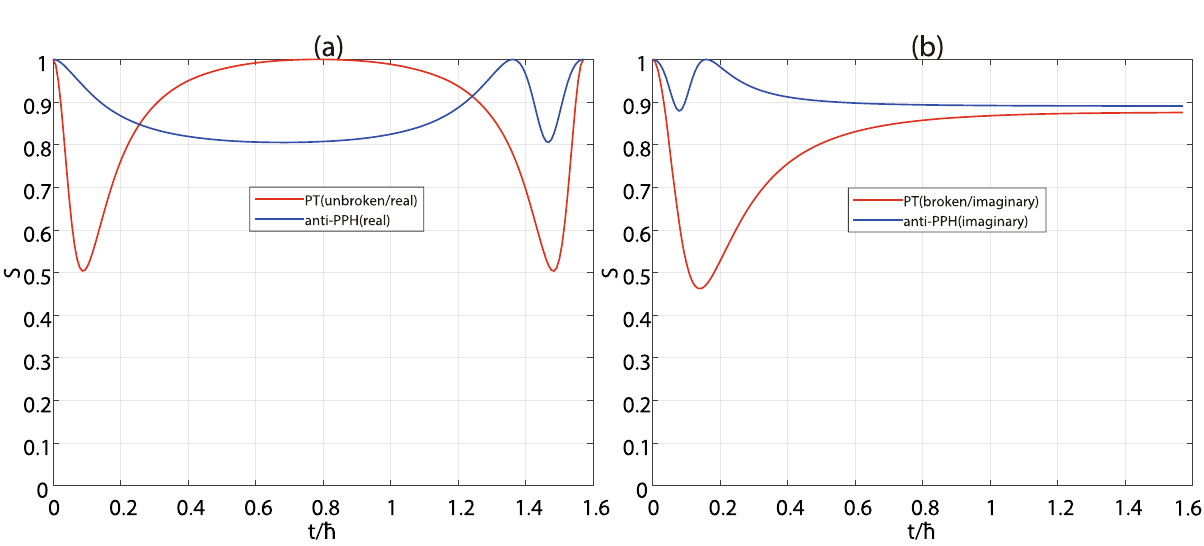
Figure 4. Distinguishability of the entropy dynamics of the anti-PT-symmetric and PPH systems. ( a ) With |+� input in the first step, the anti-PT-symmetric system can be distinguished from other systems because the entropy dynamics are constant 1 in general cases (see the black solid lines with mark ’x’). In some cases, it can also lead the entropy dynamics to be a constant 1 when the system has PT-symmetry or Hermiticity, but they can be distinguished between each other and the anti-PT-symmetric systems in different phases by inputting | 0 � further as described in the main text and illustrated in ( b ). ( b ) Distinguishablity with | 0 � input. The patterns of the four cases are typical and distinguished. ( c ) With |−� input in the second step, the PPH system can be identified because the entropy dynamics are identical to that with |+� input, which can be apparently seen when comparing the green solid or dashed line with mark ’o’ in ( a ) and that in ( c ).